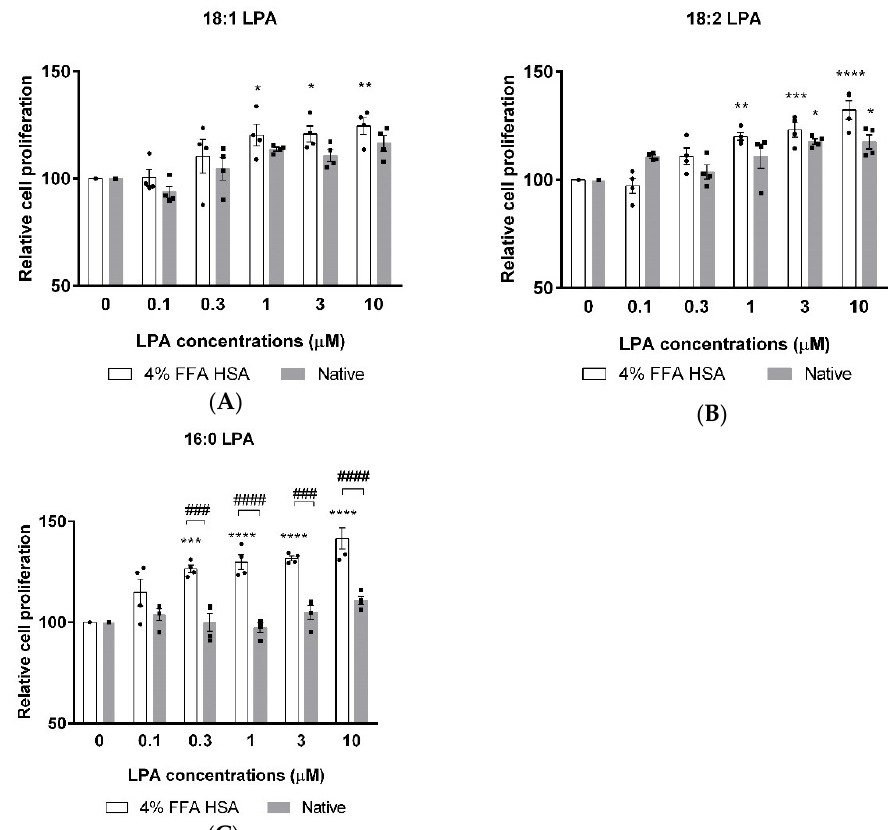
Figure 2. Relative cell proliferation after 18:1 ( A ), 18:2 ( B ) and 16:0 ( C ) LPA treatment in combination with HSA (4% FFA HSA, white columns) or alone (native, grey columns). (* p < 0.05, ** p < 0.01, *** p < 0.001, **** p < 0.0001 vs. control (0 µM LPA), ### p < 0.001, #### p < 0.0001, n = 4 in each group, two-way ANOVA, followed by Tukey’s multiple comparison test). Data are presented as % of control and mean ± SEM.